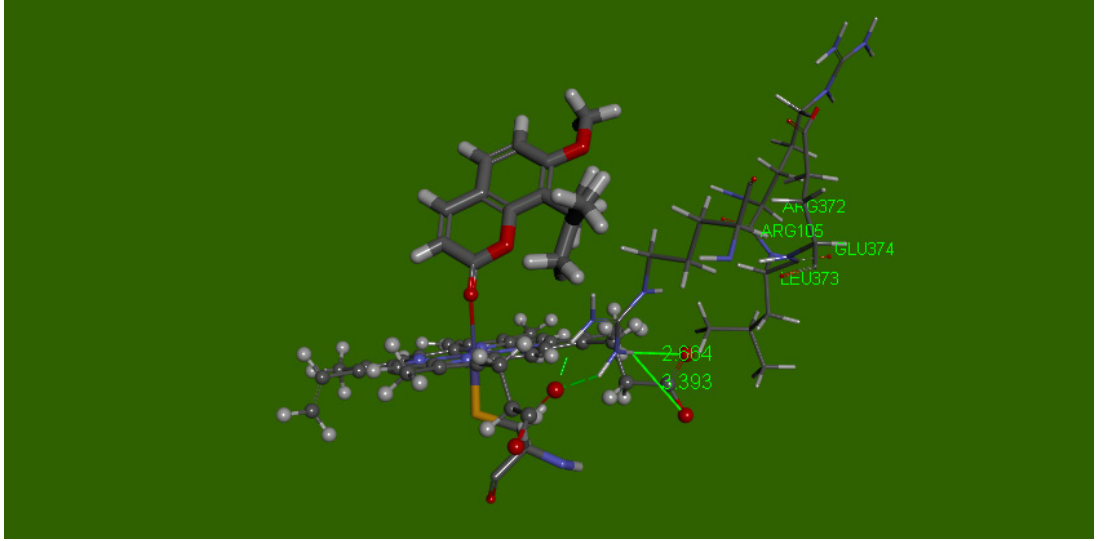
Figure 14. Pose 1 after docking of osthole with O(carbonyl) bound to iron, Ost1. This was selected to run DFT calculations.